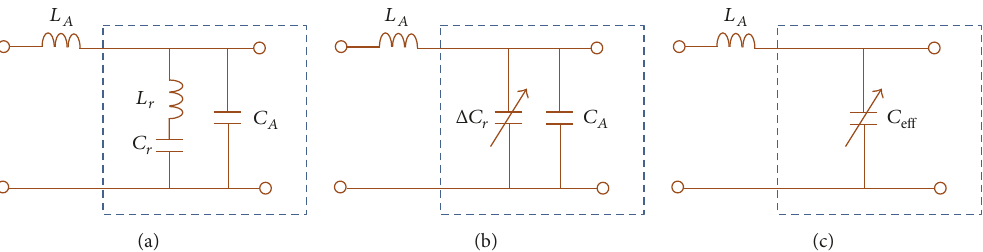
Figure 2: (a) An acoustic equivalent circuit using the impedance analogy. (b) The effective impedance circuit of SHS. (c) The effective impedance circuit of the two